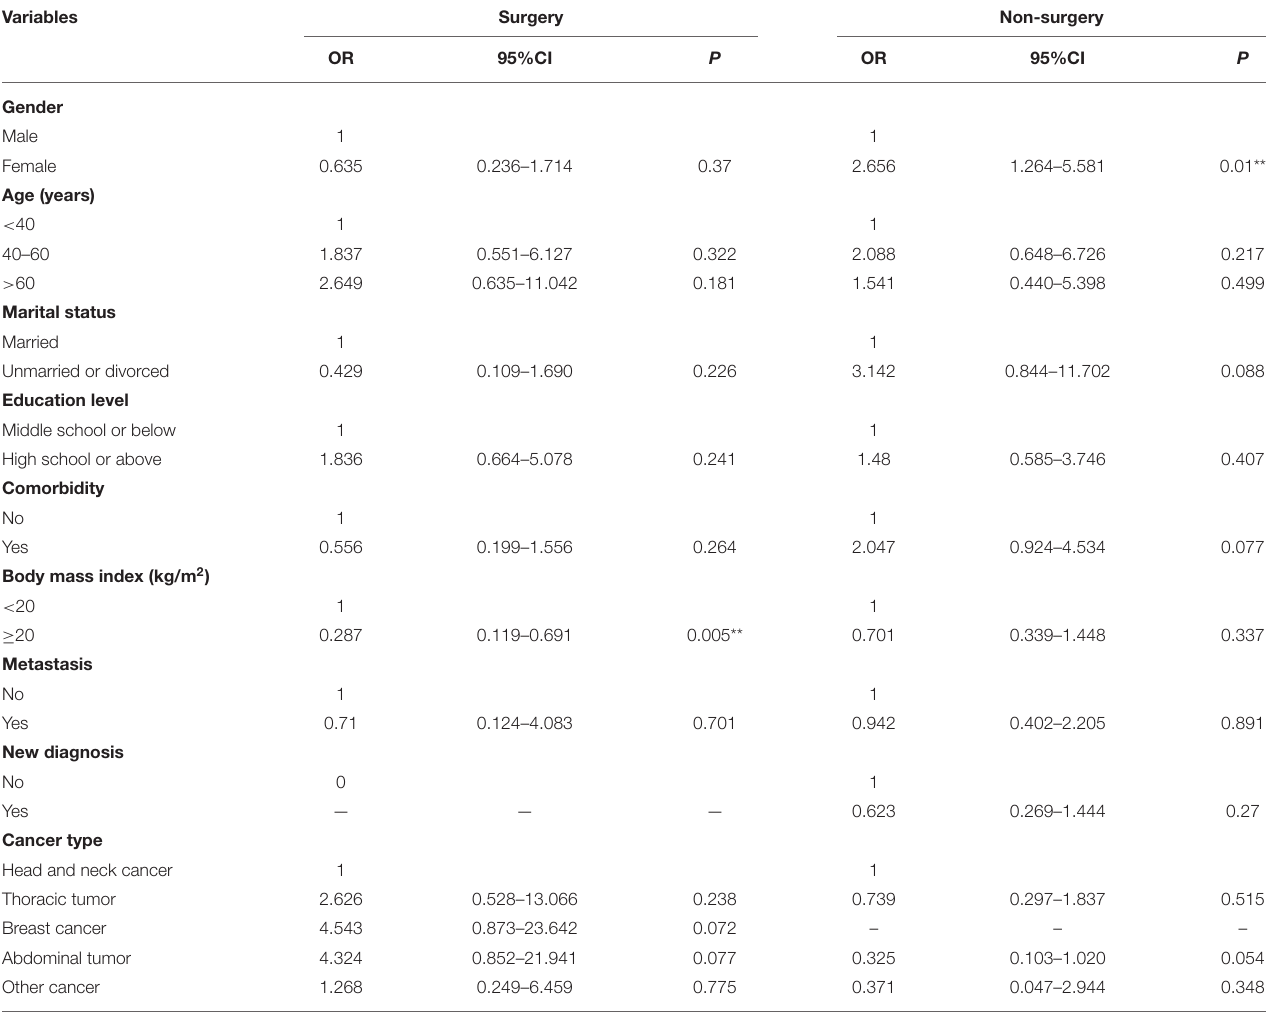
TABLE 4 | Significant predictors of sleep disturbance stratified by surgery in patients with cancer.